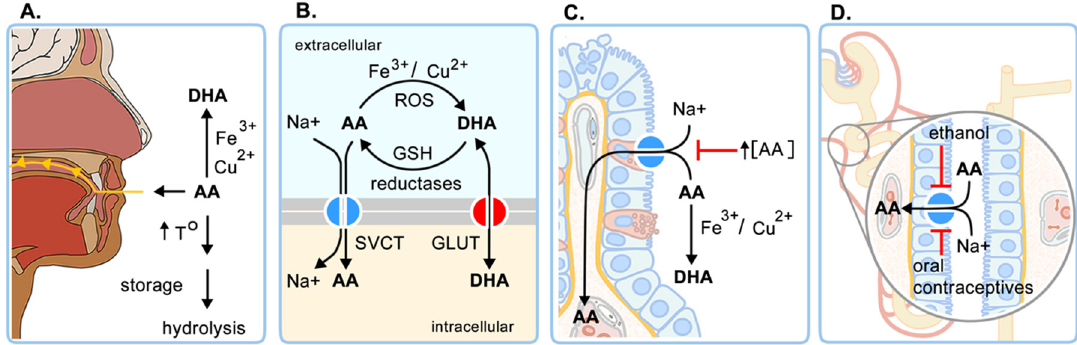
Figure 2. Regulators of vitamin C homeostasis. ( A ) Intake; ( B ) transport and recycling; ( C ) intestinal absorption; ( D ) kidney reabsorption. Effects of different molecules and conditions are also indicated. DHA: dehydroascorbic acid, AA: ascorbic acid, ROS: reactive oxygen species, GSH: reduced glutathione, SVCT: sodium-vitamin C transporter, GLUT: glucose transporter. Translated and modified from Villagrán et al. [9].